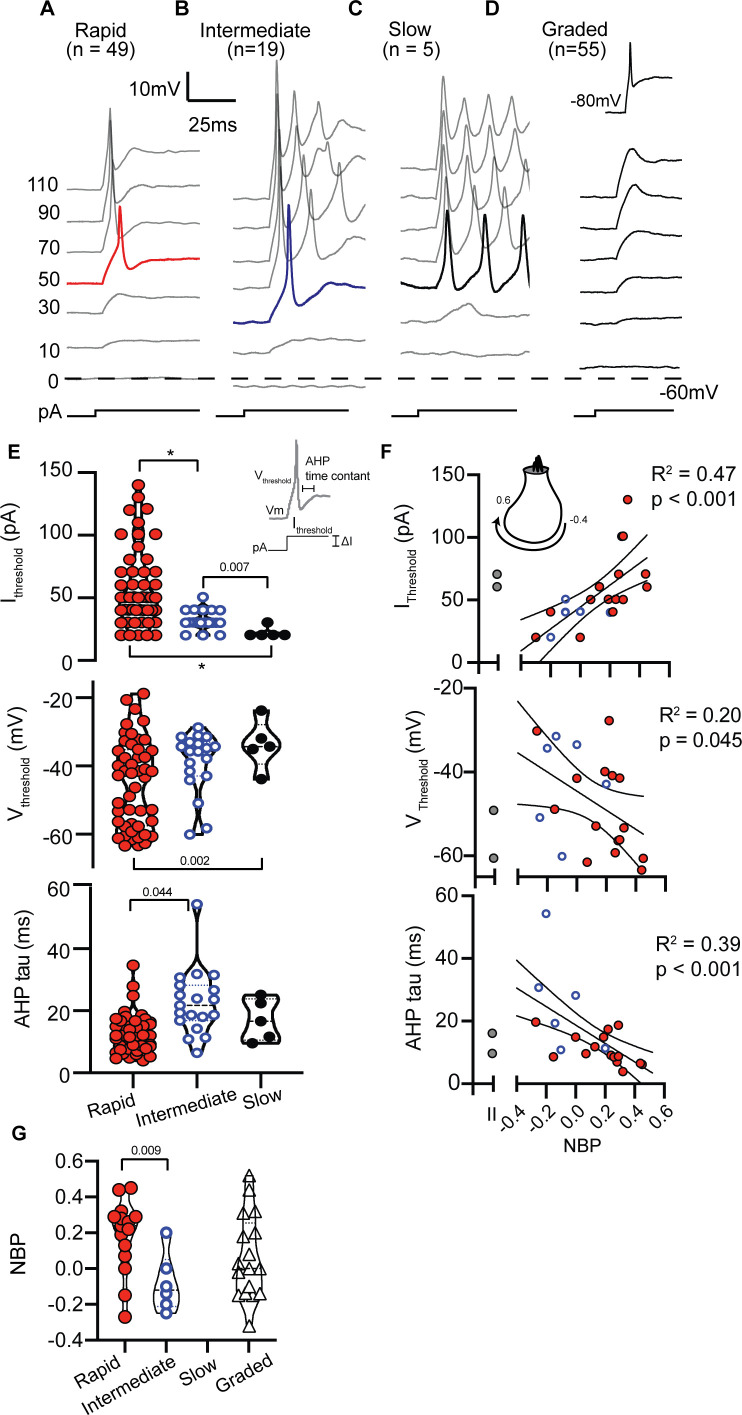
SGN can be qualitatively grouped by firing patterns in response to step current injections.(A) Rapidly-accommodating neurons fire a single action potential. (B) Intermediately-accommodating neurons fire more than one action potential and eventually reach a steady-state potential. (C) Slowly-accommodating neurons fire multiple actions and do not reach a steady-state potential. (D) Graded-response neurons do not produce an action potential, but produce graded-depolarization in response to incrementing current steps. These neurons are capable of firing action potentials after their membrane potential are held at −80 mV (inset). (E) Action potential features including current threshold (Ithreshold), voltage threshold (Vthreshold), and after hyperpolarization potential time constant (AHP tau) vary among spiking neurons. The p-values indicate when two means were assessed to be significantly different (see Materials and methods); asterisks indicate p<0.001. (F) Action potential features were significantly correlated with normalized basal position (NBP). As NBP values increased, current thresholds increased (r(20) = 0.68, p=0.0007), voltage thresholds hyperpolarized (r(20) = −0.45, p=0.045), and AHP time constants became faster (r(20) = 0.62, p<0.0001). Best fit lines with 95% confidence intervals are plotted to show the gradients along the normalized basal position axis. (G) The distribution of firing pattern subgroups as a function of NBP shows a significant relationship between the firing-pattern subgroup and NBP (p=0.0097, t-test), with rapidly-accommodating neurons found primarily on the modiolar-face and intermediately-accommodating neurons found on the pillar-face of the inner hair cell. Graded-firing neurons are found throughout the NBP scale on both the modiolar and pillar faces of the hair cell.Figure 2—source data 1.Current-clamp features versus normalized basal position data set for Figure 2F.